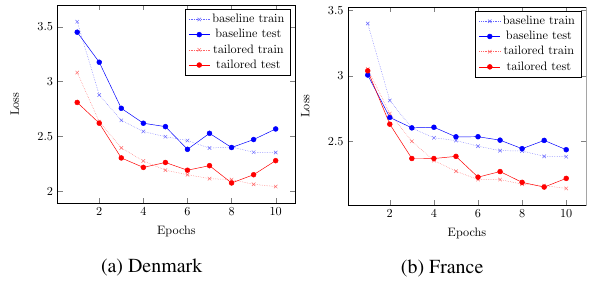
Figure 3. Convergence of the loss for the train and test datasets of each country during the training of the Mask R-CNN with the default and tailored